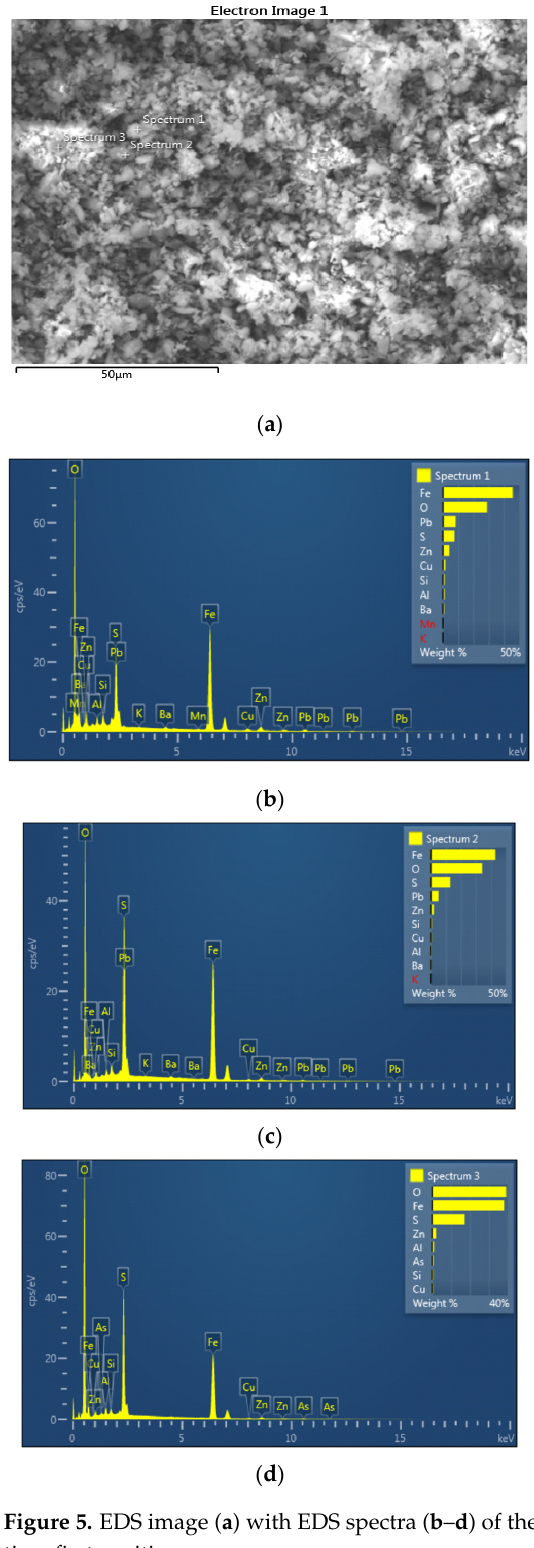
Figure 5. EDS image ( a ) with EDS spectra ( b – d ) of the jarosite sample recorded at 1000× magnification; first position.